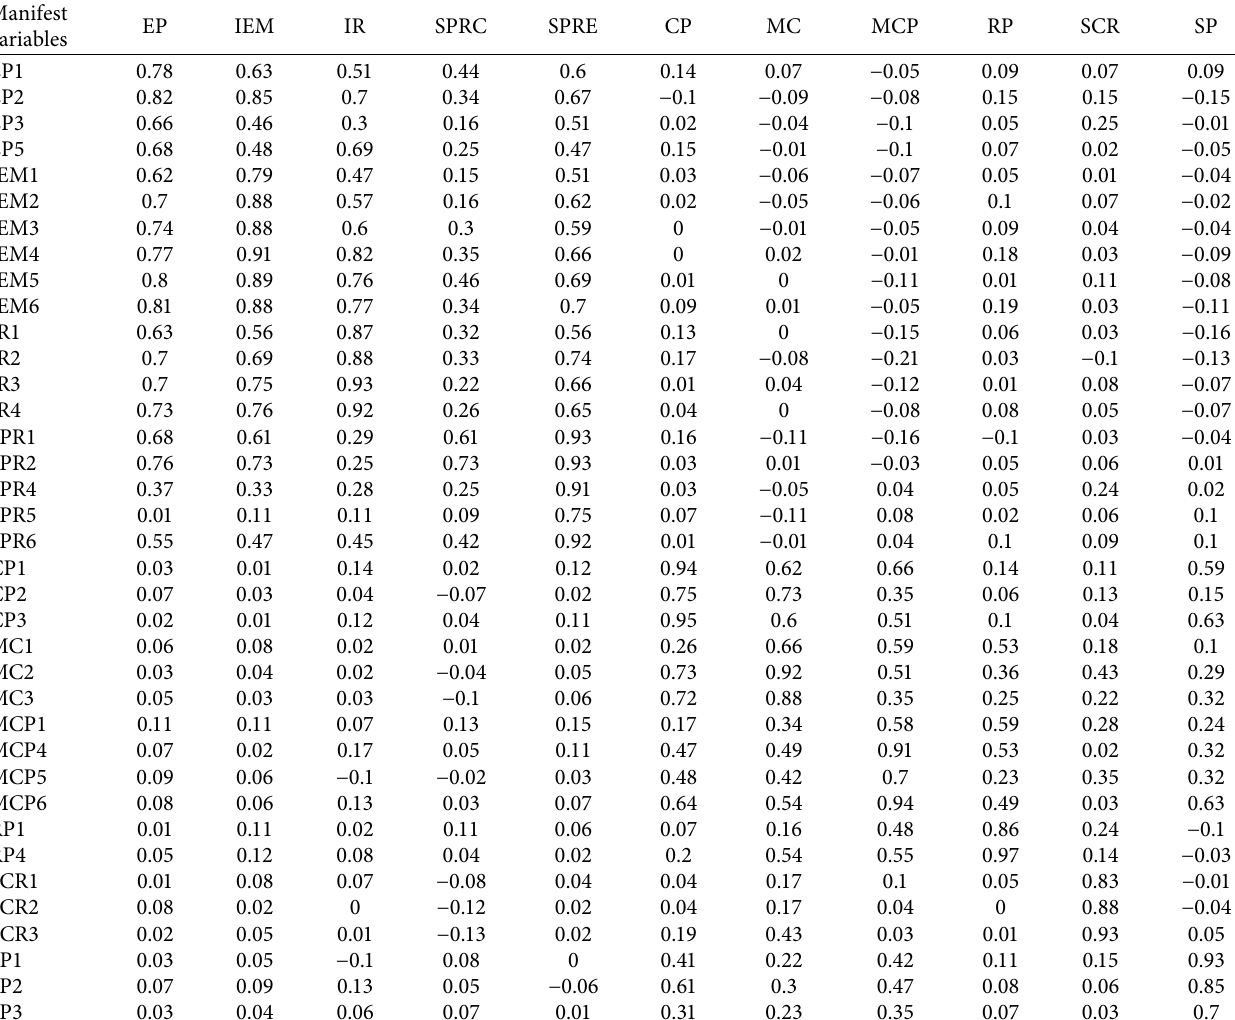
Table 11: Cross-loadings